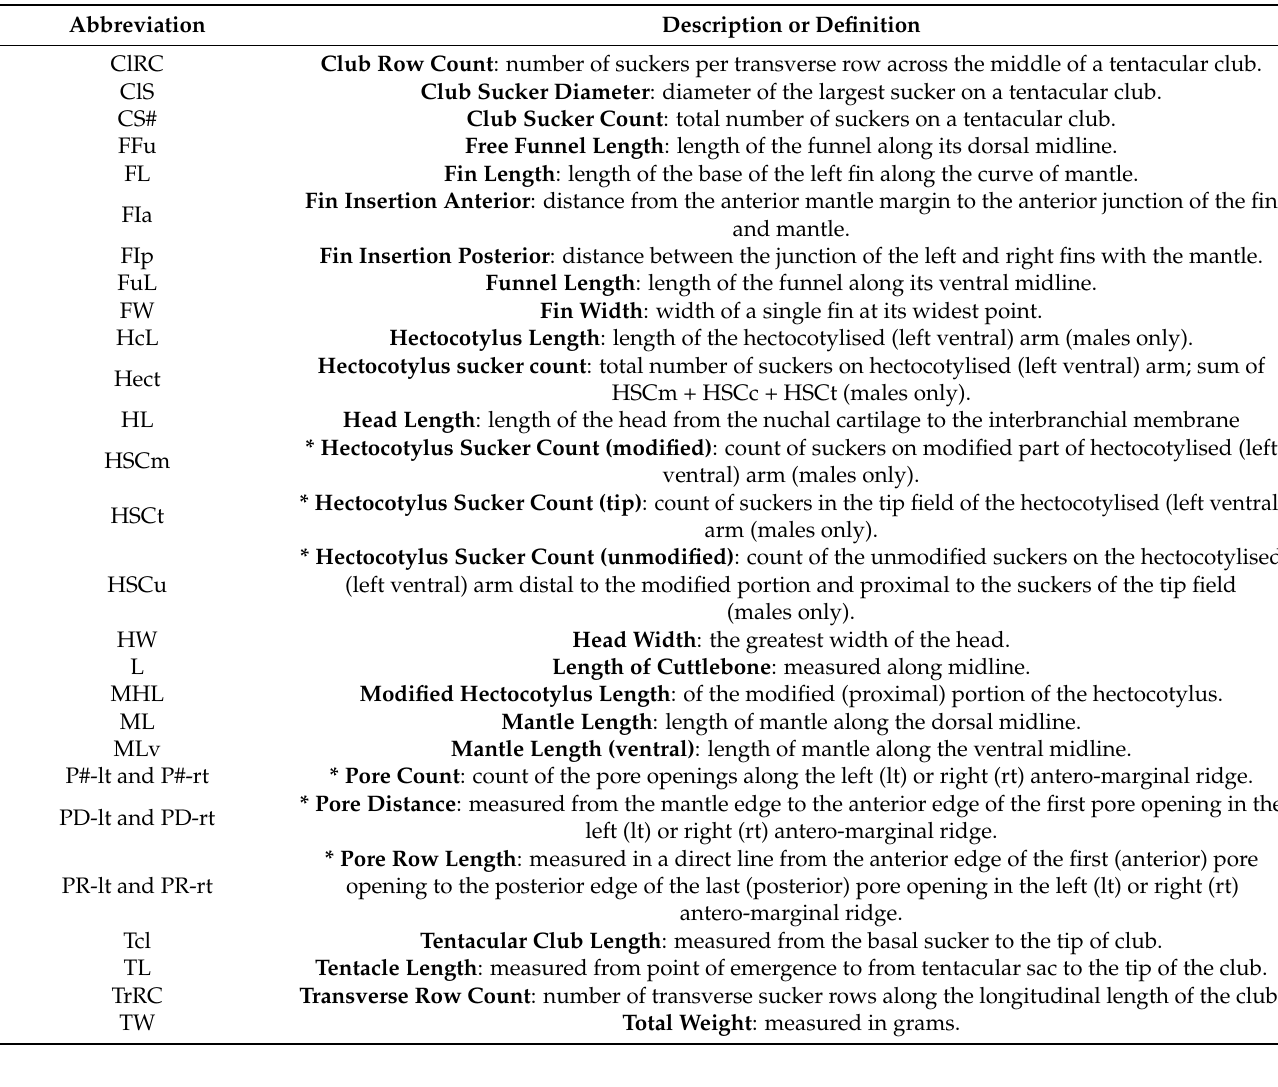
Table A2. Morphometric measurements of male Sepia typica. Sample size ( n ), minimum